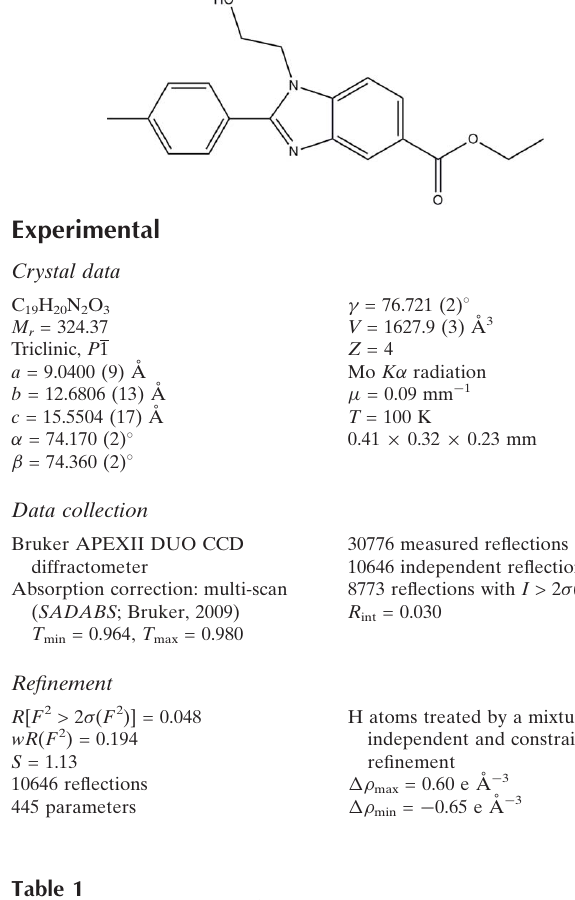
Hydrogen-bond geometry (A˚ , (cid:3)